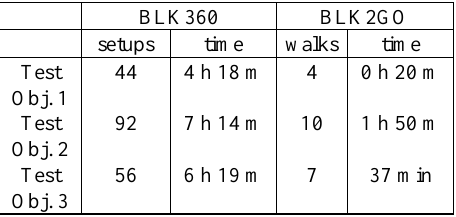
Table 1 . Time costs of using different